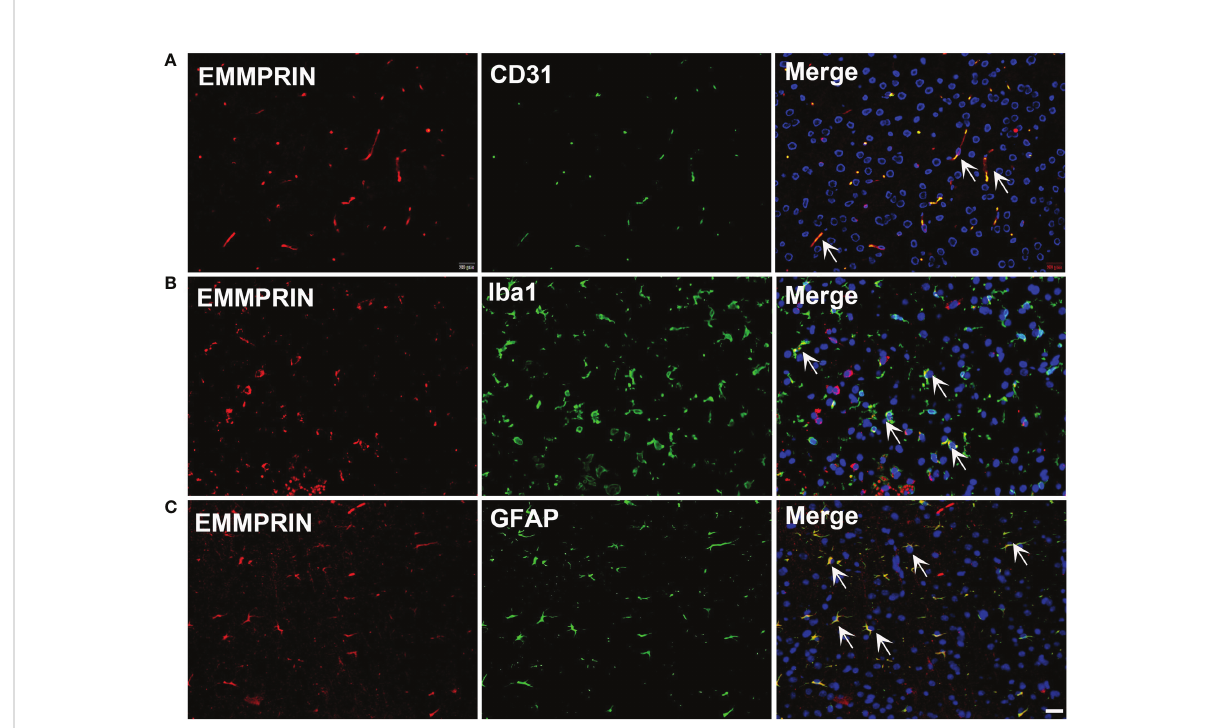
FIGURE 1 ICH increases the expression of EMMPRIN in astrocytes, microglia and endothelial cells. Representative images of the co-expression of EMMPRIN with CD31 ( A , endothelial cell marker), Iba1 ( B , microglia/macrophages), and GFAP ( C , astrocytes) in mouse brain sections at 3d post- ICH. Images are acquired in the perihematoma region. Scale bar = 20 m